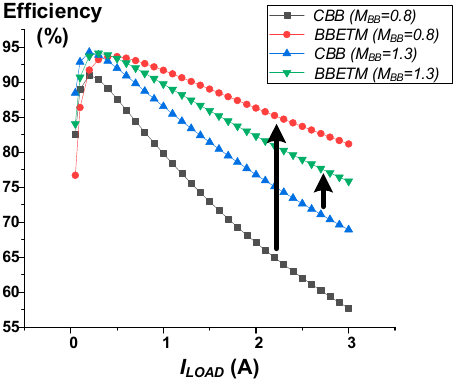
Figure 18. Simulated efficiency plot of a buck-boost converter with ETM at different load currents.